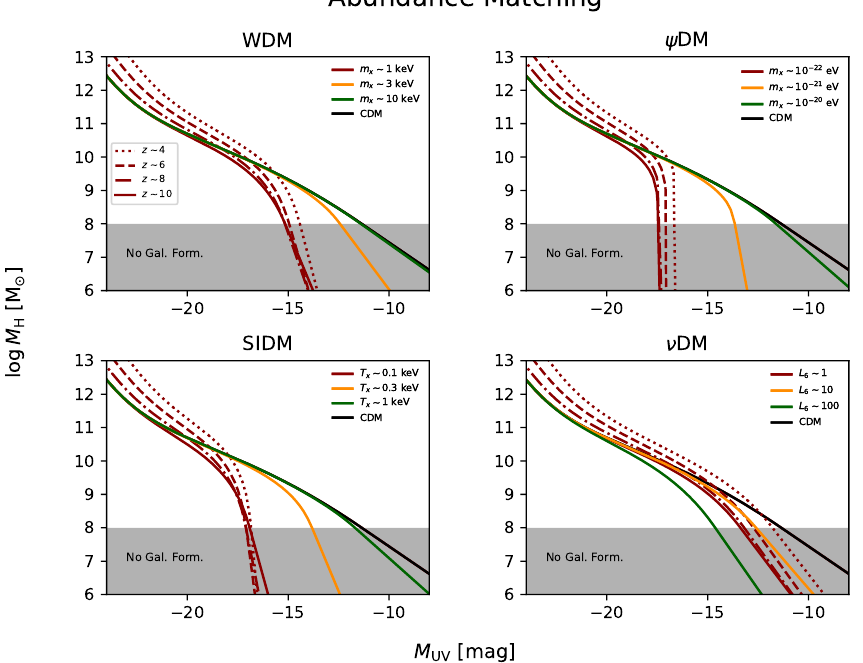
Figure 3. Relationship between the halo mass M H and the UV magnitude M UV , derived from the abundance matching of the observed UV luminosity function and the halo mass function (see text for details) in different DM scenarios. Different line styles illustrate the evolution with redshift (only plotted for one value of the astroparticle property), as reported in the legend. Different colors illustrate the change in the mass function at z ∼ 10 when varying the astroparticle property, as detailed in the legend; for reference, the black line refers to the standard CDM. In all panels, the grey shaded area marks the region below the threshold halo mass M GF where primordial galaxy H formation becomes inefficient (see Section